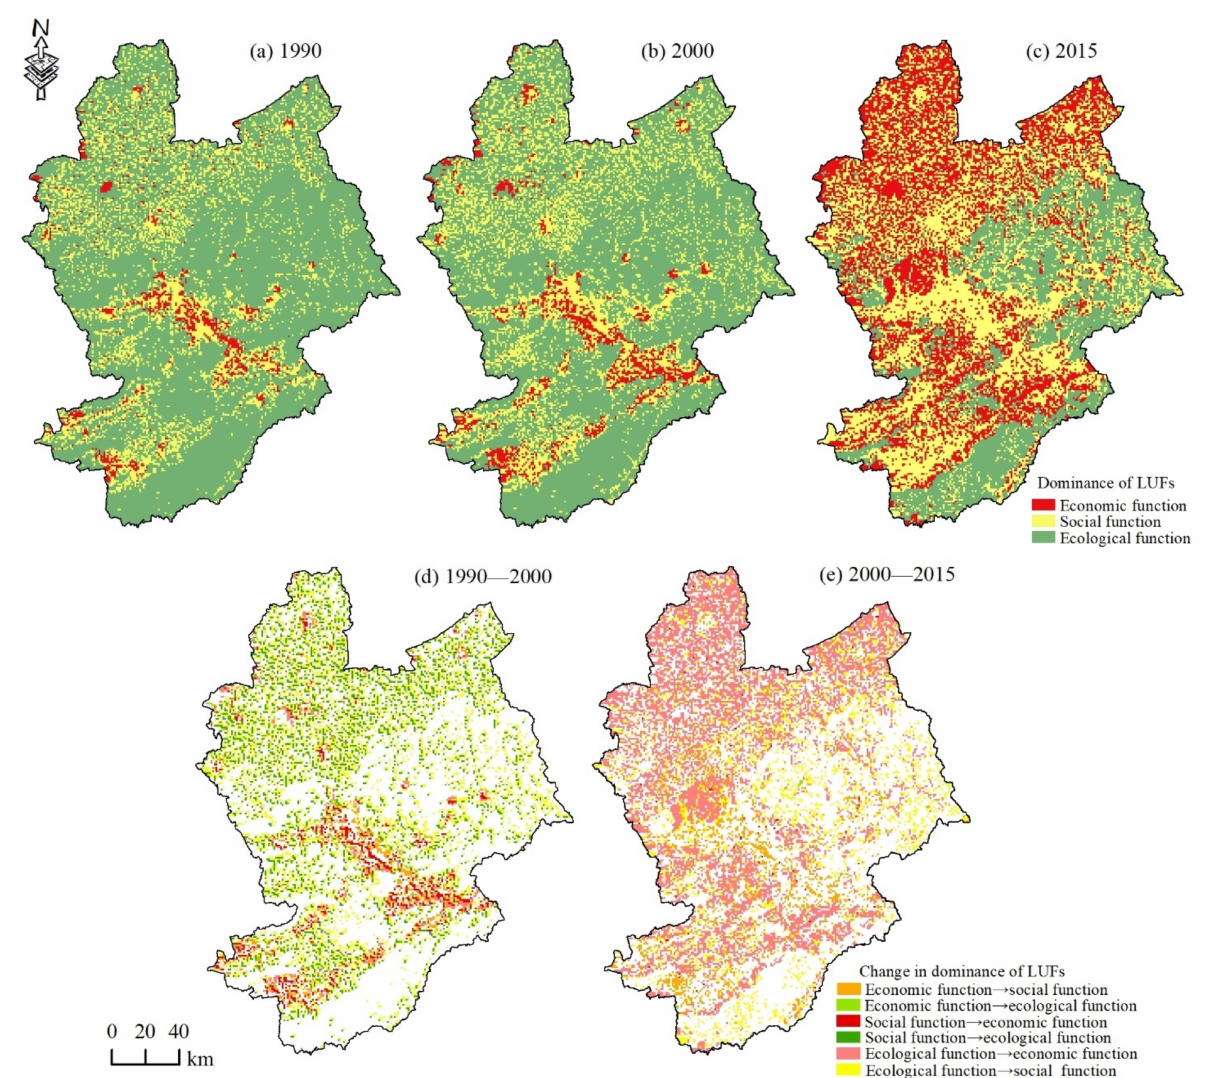
Figure 7. Spatial evolution of dominance of LUFs at grid scale in Zhangjiakou City in